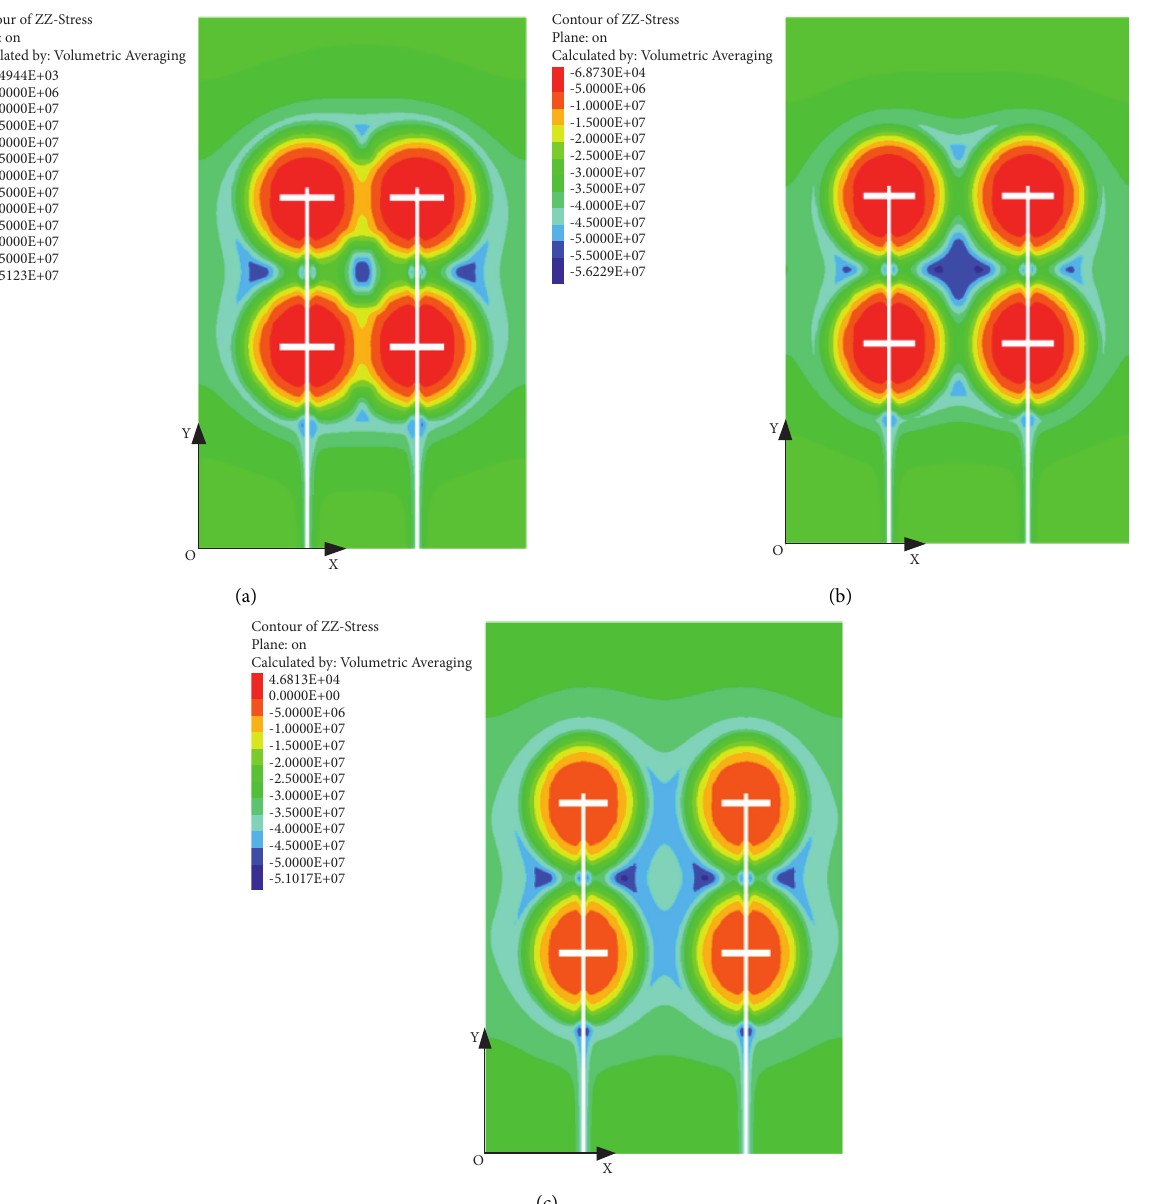
Figure 16: Vertical stress contour map around the slot with different spacings in Section 2. (a) 3.0m. (b) 4.0m. (c)